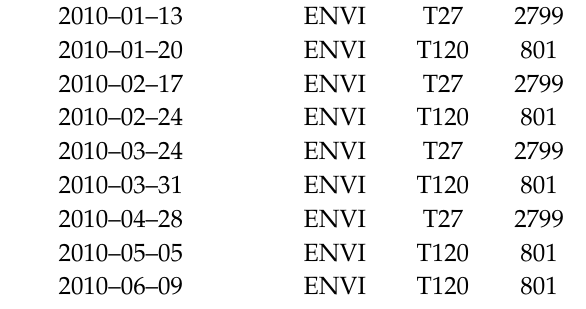
Table A2. Data set of MST pairs selected using MST methods and γ ( i , j ) as a weighting criterion. First and second epochs of each pair are given in YYYY–MM–DD format, perpendicular baseline b ⊥ and temporal baseline ∆ t are given in meters and days,